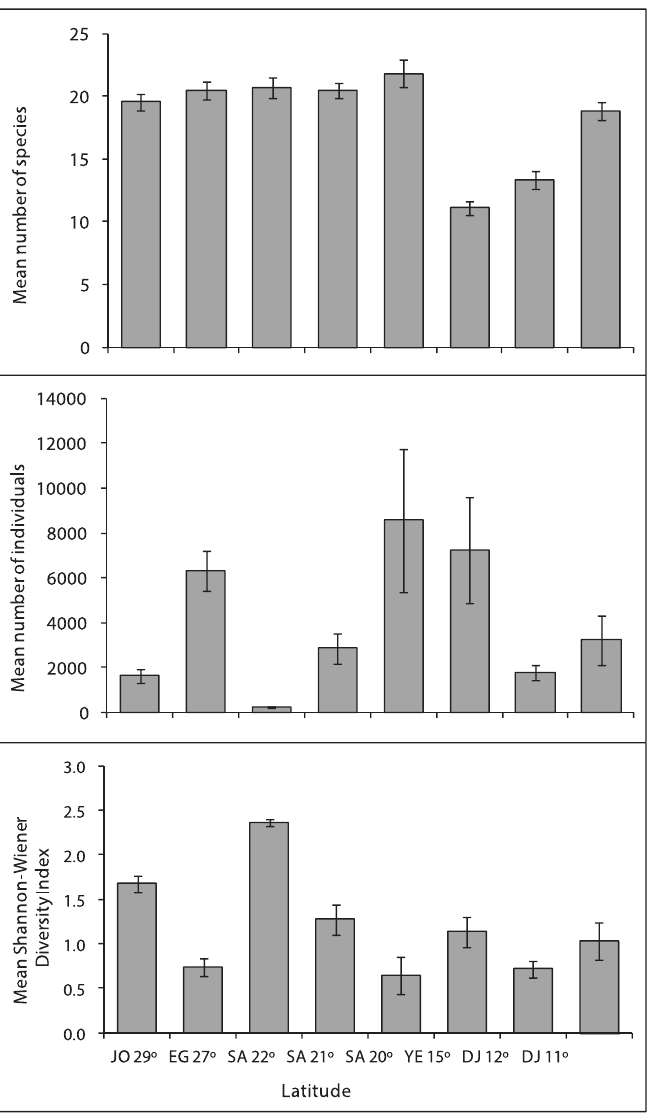
Figure 3. Mean number of fish species, mean number of individuals, and mean Shannon-Wiener Diver- sity Index in coral reef along the Jordan latitude 29°; Egypt latitude 27°; Saudi Arabia latitude 22, 21, 20°; Yemen 15° and Djibouti latitude 12,